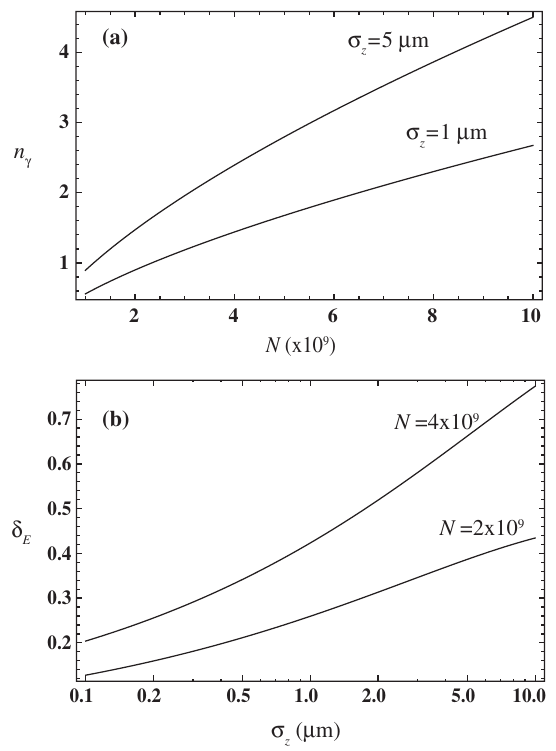
FIG. 4. (a) Beamstrahlung photons emitted per electron n (cid:4) versus N for bunch lengths (cid:6) z ¼ 1 (cid:1) m and 5 (cid:1) m . (b) Beamstrahlung induced energy spread (cid:8) E versus bunch length (cid:6) z for N ¼ 2 (cid:7) 10 9 and N ¼ 4 (cid:7) 10 9 .